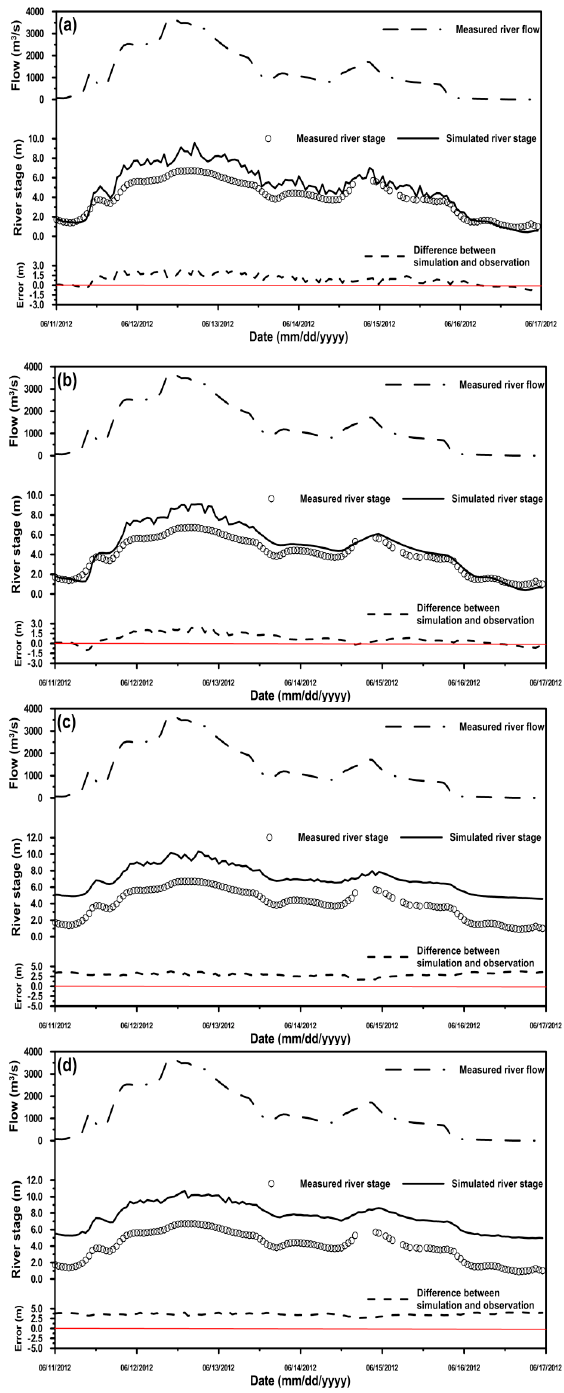
Figure 10. A comparison of the simulated and observed river stages at the Mashan Bridge under the high flow condition using the 2D model with the: ( a ) original cross-section data; and resampled cross-section data according to: ( b ) the linear interpolation method; ( c ) the IDW method; and ( d ) the NN method.